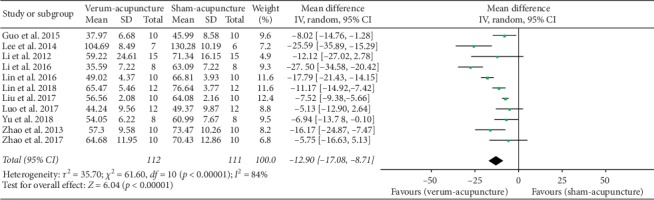
Forest plot of verum- versus sham-acupuncture in escape latency.